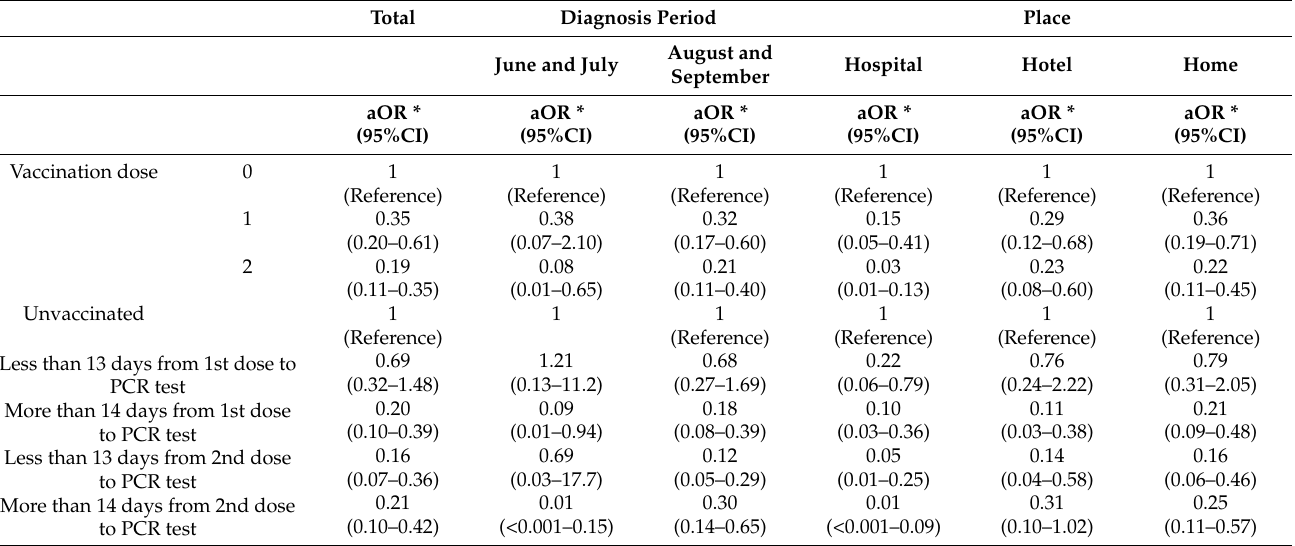
Table 4. Adjusted odds ratio (aOR) against COVID-19 according to diagnosis period and place of care or